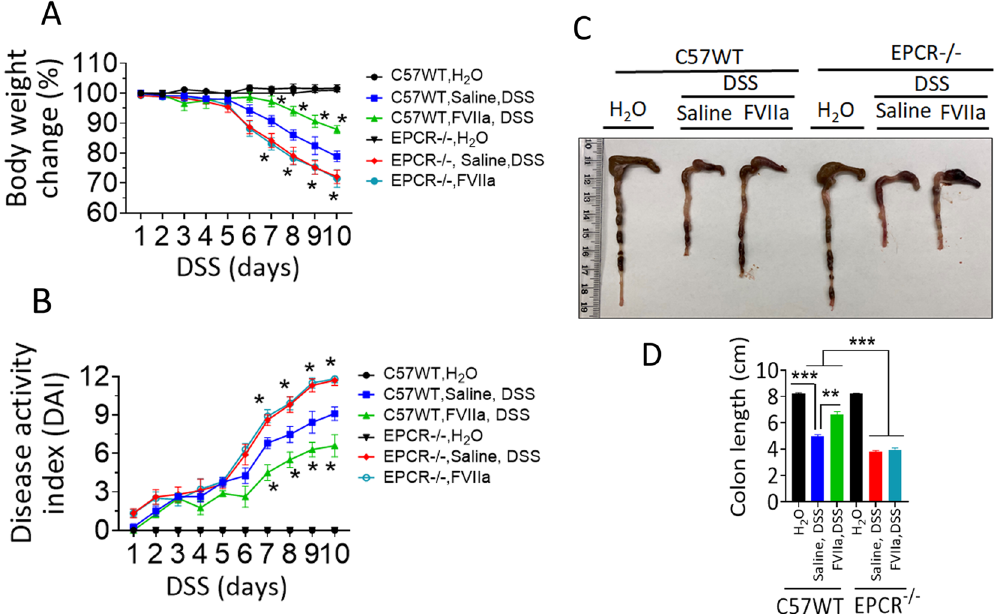
Figure 6. Pharmacological doses of FVIIa protects against intestinal bleeding, bodyweight loss, and disease activity in DSS-induced colitis in wild-type but not EPCR −/− mice. Wild-type or EPCR −/− mice were administered with a control vehicle (saline) or recombinant hFVIIa (250 µg/kg) every alternate day during the 10-day course of colitis, starting at day 1 of DSS-treatment. The body weight loss ( A ) and disease activity index ( B ) were measured. ( C ) Representative images of the colon collected from control and FVIIa treated mice. ( D ) The colon length measurements. Data are the mean ± SEM of 2 independent experiments of 8 mice/group. In panels A and B, data of DSS-fed wild-type mice were compared with FVIIa-treated DSS-fed wild-type mice, DSS-fed EPCR −/− mice, or FVIIa-treated DSS-fed EPCR −/− mice to determine statistical significance. * P < 0.05; ** P < 0.01; *** P <